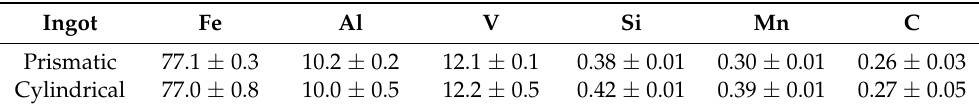
Table 2. Chemical compositions by WDXRF except for C by AAS (at. %). The error represents the standard deviation obtained from different zones of the